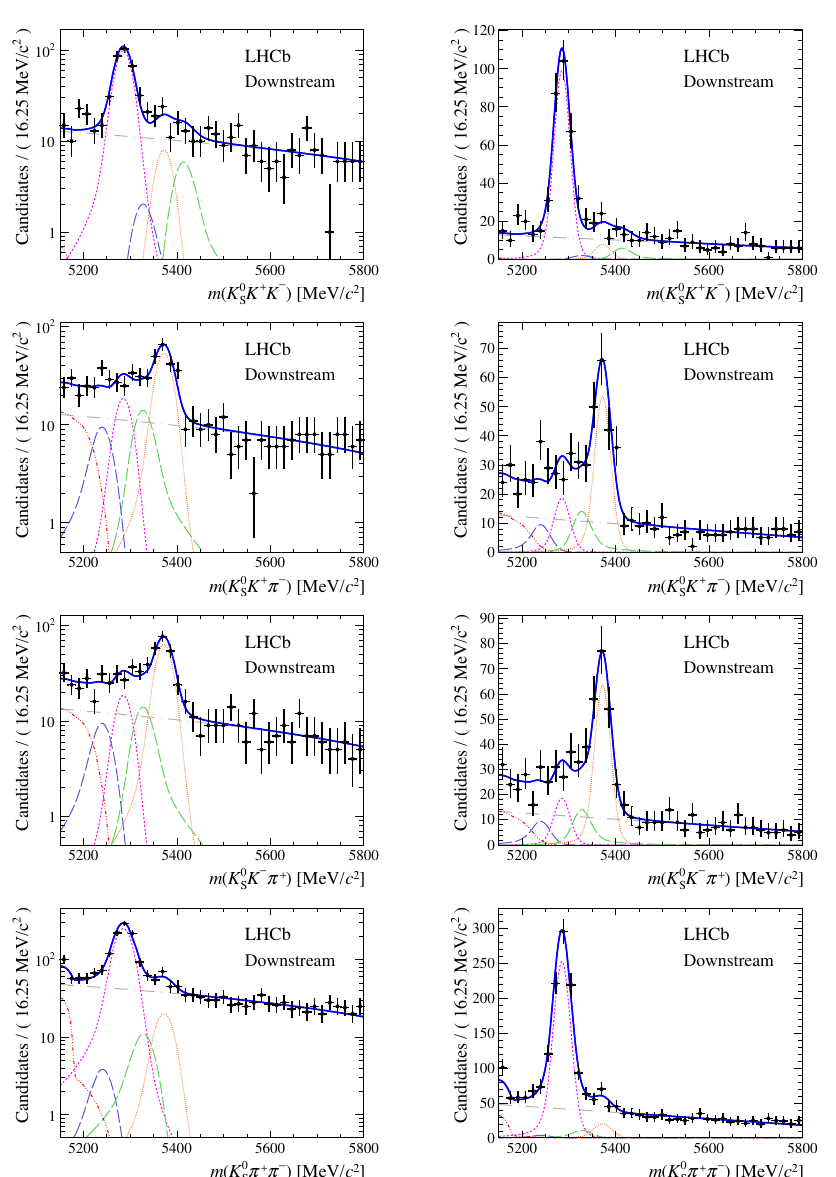
Figure 3 . Results of the simultaneous (cid:12)t to data (downstream, 2011) with the BDT optimisation corresponding to the favoured decay modes. The modes K 0 K 0 (cid:25) + (cid:25) (cid:0) are shown from top to bottom. The left-hand side plots show the results with a logarithmic S scale and the right-hand side with a linear scale. Legend is similar to that of plots shown in (cid:12)gure 1.